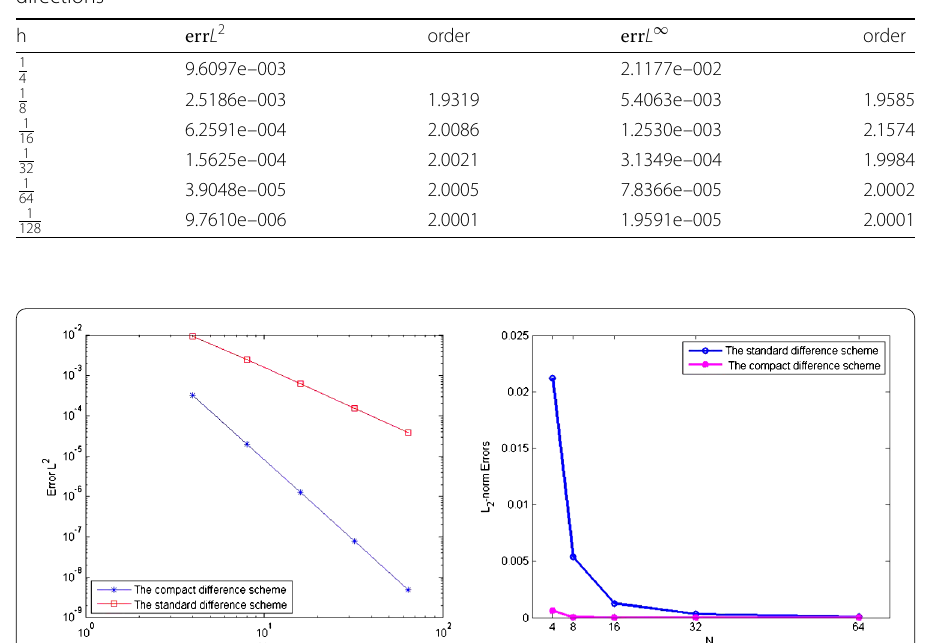
Table 2 The comparison of the l 2 -norm and the l ∞ -norm when τ = h x = h y for O ( h 2 x + h 2 y ) standard central difference scheme, at different values of the step size (for N = 4,8,16,32,64,128) in the x and y